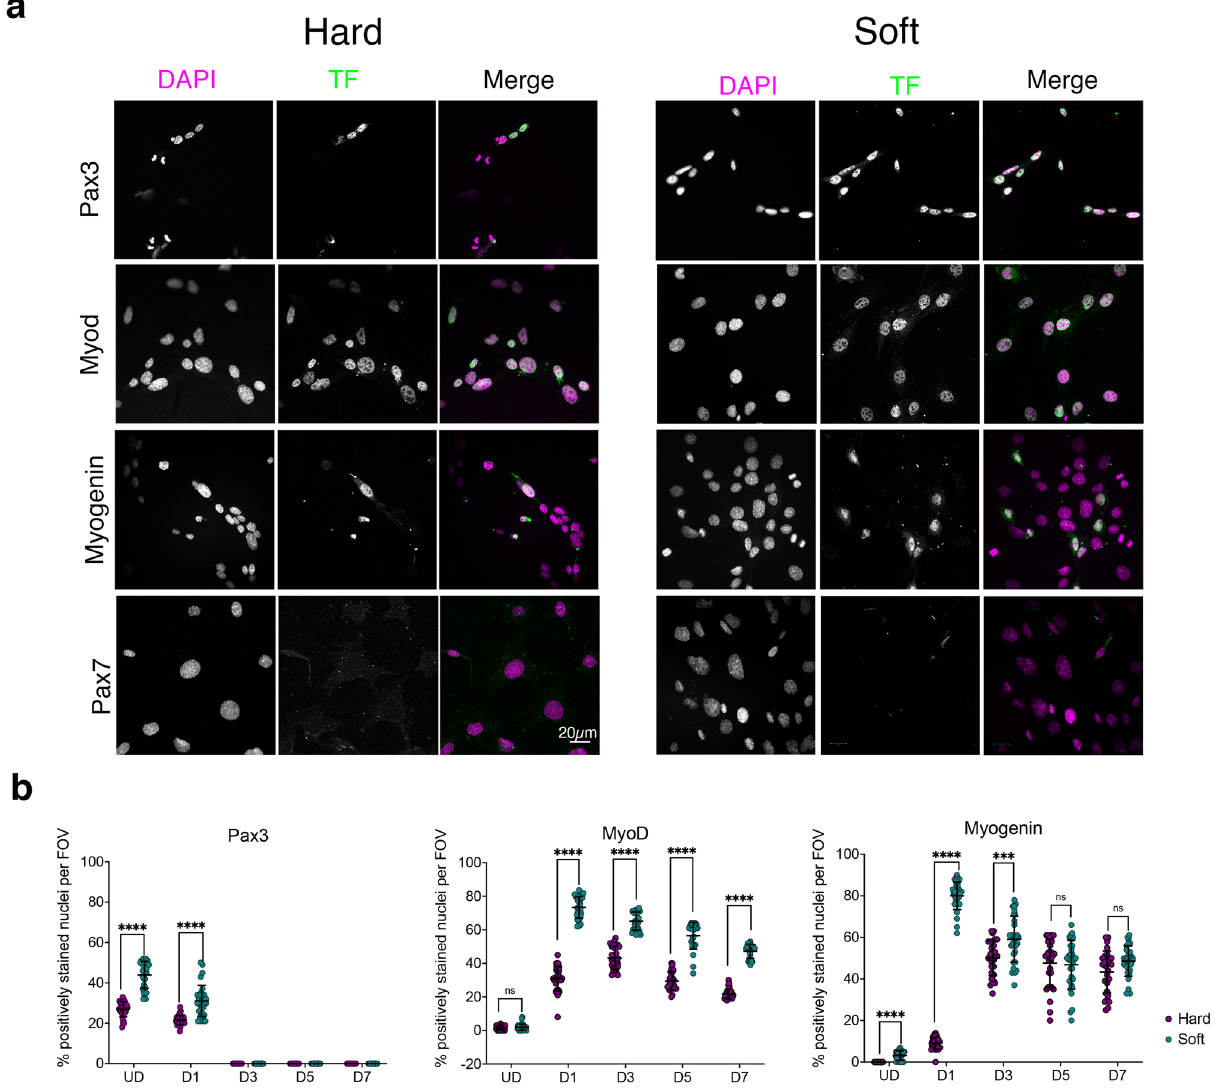
Figure 4. Immunostaining for myogenic factors in C1F cells cultured on hard or soft surfaces. ( a ) Example images of cells stained for DAPI and specific transcription factor, shown in greyscale for each channel, and as magenta and green respectively in the merged image. ( b ) Quantification of the number of nuclei staining positively for each transcription factor (Pax3, MyoD and myogenin) over time on hard (magenta) and soft (green) surfaces. ****p < 0.0001, ***p < 0.001. ns was significant (Fig. 6b). However, the level of Notch1 in cells cultured on hard surfaces at D1 is significantly higher than that for cells cultured on soft surfaces (Fig. 6c). This is unexpected because Notch1 expression should decrease at D1, as the time cells cease proliferating and start differentiating. MEGF10 (multiple EGF like domains 10) has been suggested to interact with Notch1 and to be significantly downregulated when C2C12 cells are induced to differentiate by serum withdrawal 23 . We found that mRNA levels of MEGF10 increased significantly between undifferentiated cells and D1 on both soft and hard surfaces (Fig. 6b). However, on soft surfaces, MEGF10 levels remained significantly elevated at D3-7 compared to UD cells, while on hard surfaces, MEGF10 levels did not (Fig. 6b). On hard surfaces, MEGF10 levels are increased significantly for cells cultured on hard surfaces at D1 (Fig. 6c) but on soft surfaces, increased significantly at D7. These expression patterns argue against the role of MEGF10 in promoting proliferation in combination with Notch1. Overall, this analysis of gene expression demonstrates that Pax3 positive C1F cells express a range of mark- ers for myogenic differentiation, with a pattern consistent with differentiation of myoblasts into multinucleated myotubes. Differential gene expression analysis of collagen genes. The WebGestalt analysis (Fig. 2e–h) showed that growing cells on hard surfaces increased gene expression for a range of extracellular matrix (ECM) and associated proteins, as well as the receptors that bind these proteins. This raised the possibility that cells